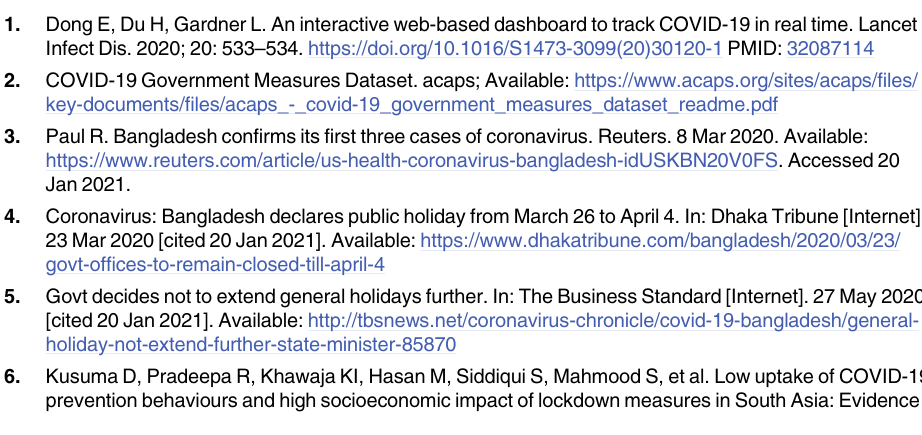
S1 Table. Response rate by district and socio-economic